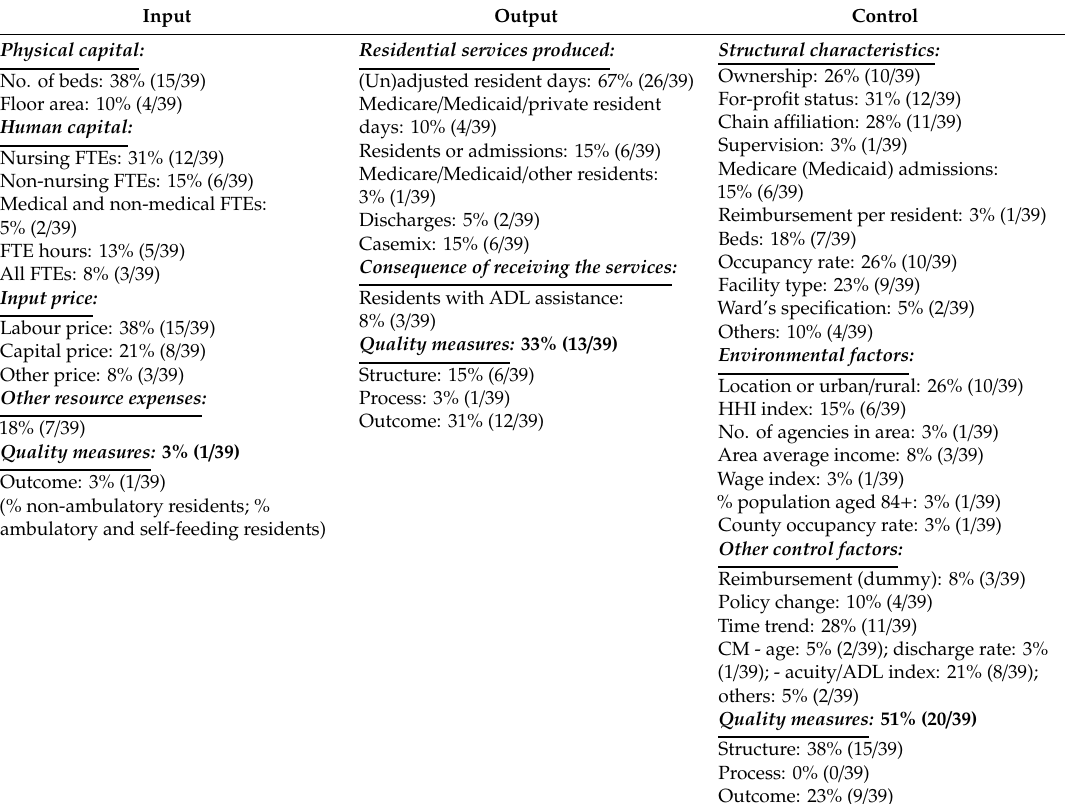
Table 2. Summary of variables used in included